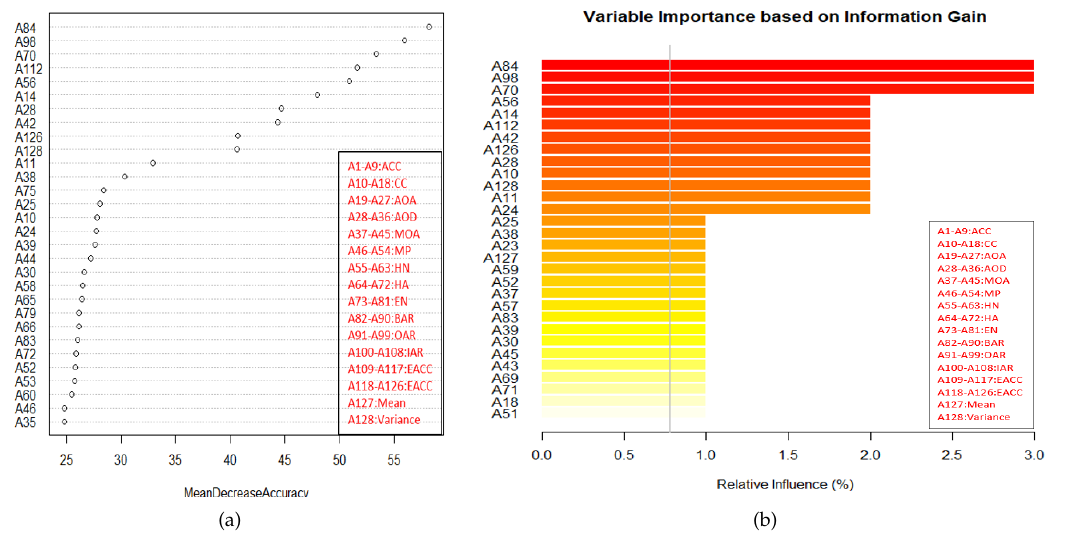
Figure 8. Variable importance (class-specific feature set) ( a ) Random forest, ( b ) Random uniform forest. Here, different range of symbols ‘Ai–Aj’ (‘i, j’ denoting a number) are used for different parametric variations of each class-specific features, as provided in the legend